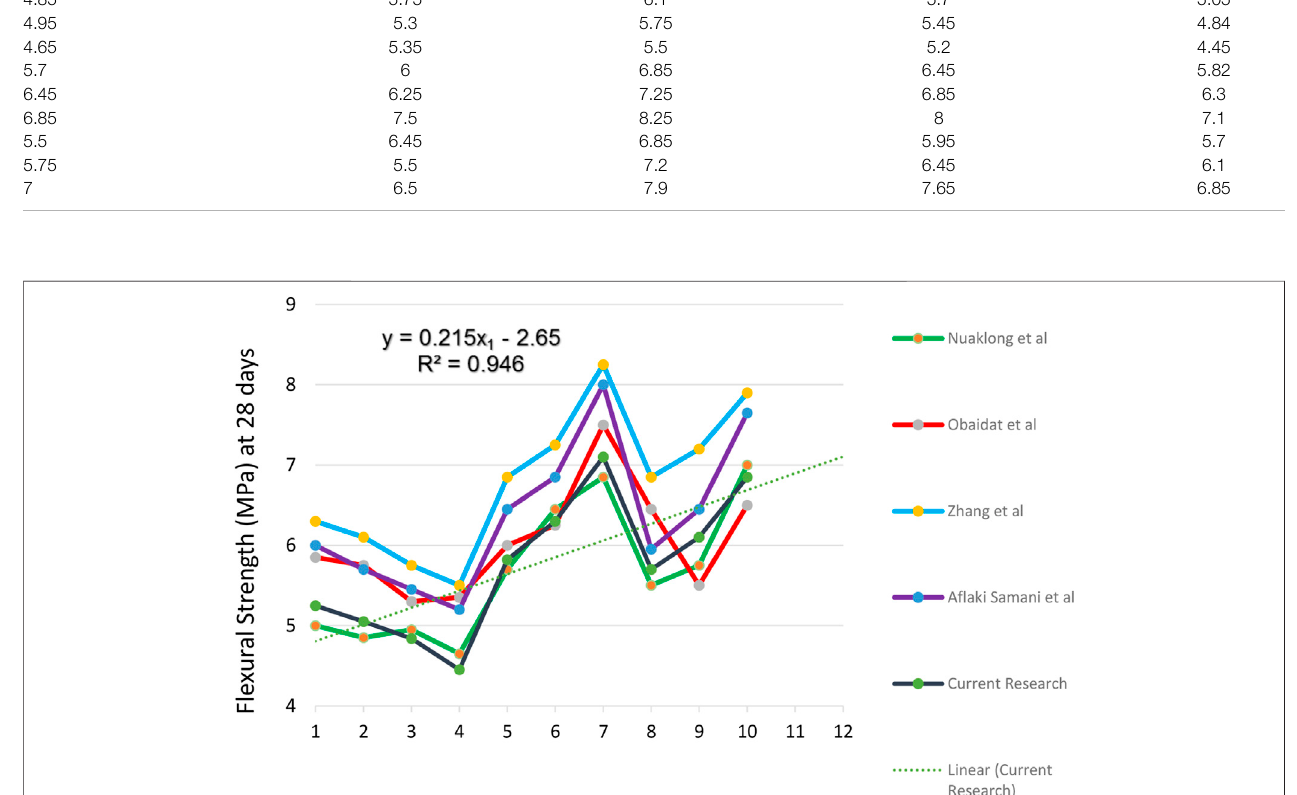
FIGURE 11 | Comparative analysis of present literature and current research for fl exural strength (MPa) at 28 days.